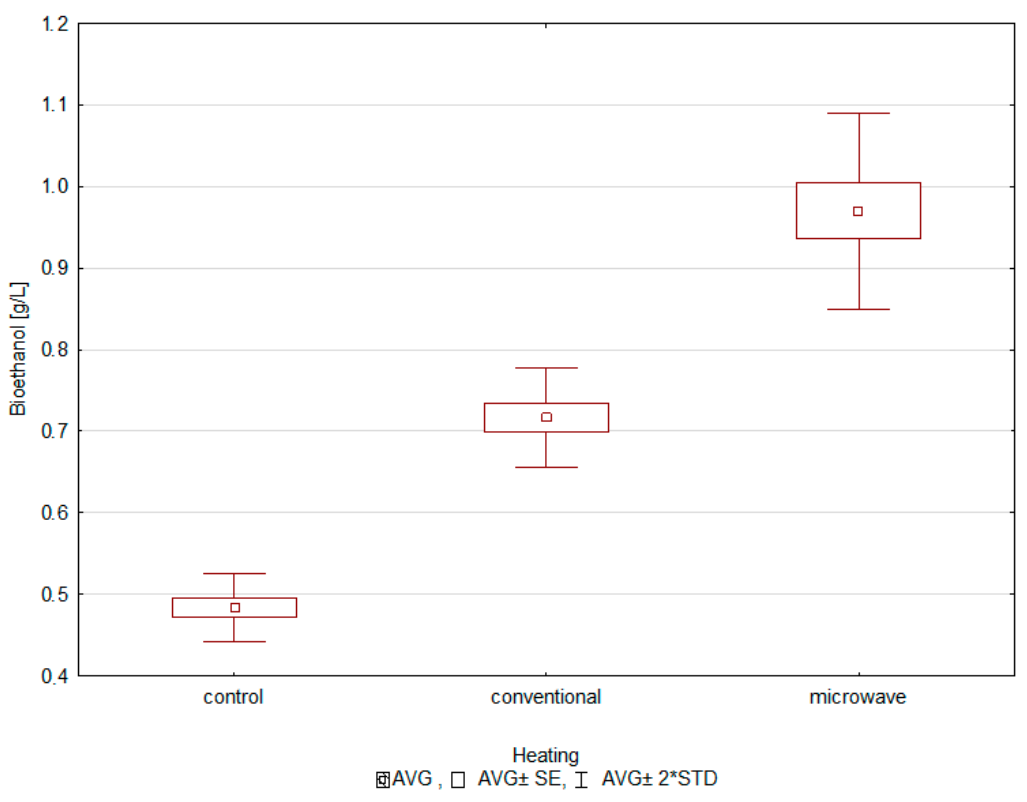
Figure 1. Concentration of bioethanol in relation to the type of